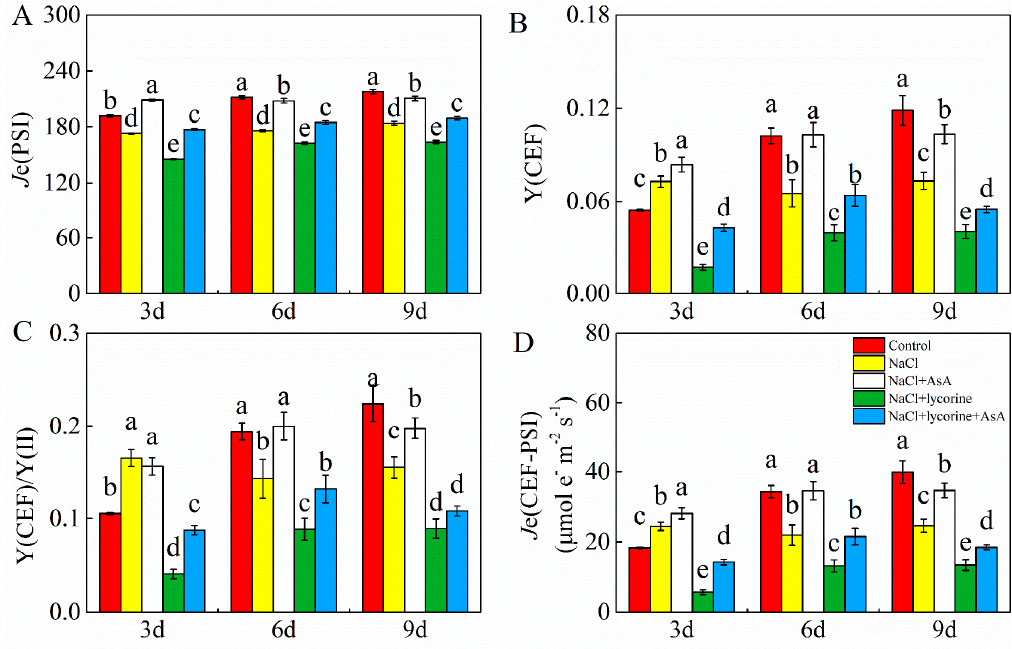
Figure 6. Values of the rate of electron transport through PSI ( J e(PSI)) ( A ), the quantum yield of cyclic electron flow (CEF) around PS I (Y(CEF)) ( B ), Y(CEF)/Y (II) ( C ), and the electron flux through CEF-PSI ( J e(CEF-PSI)) ( D ) in leaves of salt-stressed tomato seedlings with or without exogenous reduced ascorbic acid (AsA) and lycorine (AsA synthesis inhibitor) spraying. Abbreviations 3d, 6d, and 9d represent the third, sixth, and ninth day after treatment, respectively. Control, no added NaCl and sprayed with distilled water; NaCl, added 100 mmol·L –1 NaCl and sprayed with distilled water; NaCl + AsA, added 100 mmol·L –1 NaCl and sprayed with 0.5 mmol·L –1 AsA; NaCl + lycorine, added 100 mmol·L –1 NaCl and sprayed with 0.25 mmol·L –1 lycorine; NaCl + lycorine + AsA, added 100 mmol·L –1 NaCl and sprayed with 0.25 mmol·L –1 lycorine plus 0.5 mmol·L –1 AsA. Values are means ± SD ( n = 3). Values with a different letter within a sampling date are significantly different ( p < 0.05).